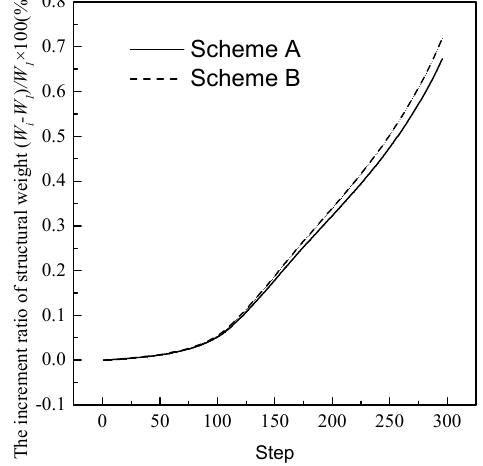
Figure 15. The change ratio of the structural weight.